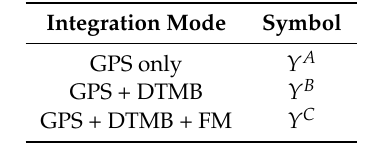
Table 2. Fuzzy rules in our system.